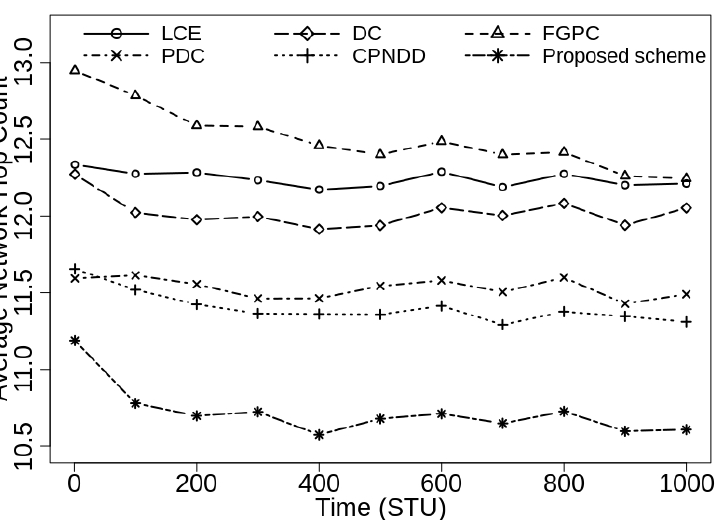
Figure 6. Comparison of average network hop count with λ = 50/s, | CS ( R i ) | = 50, α = 0.7, and | Ctlg | =